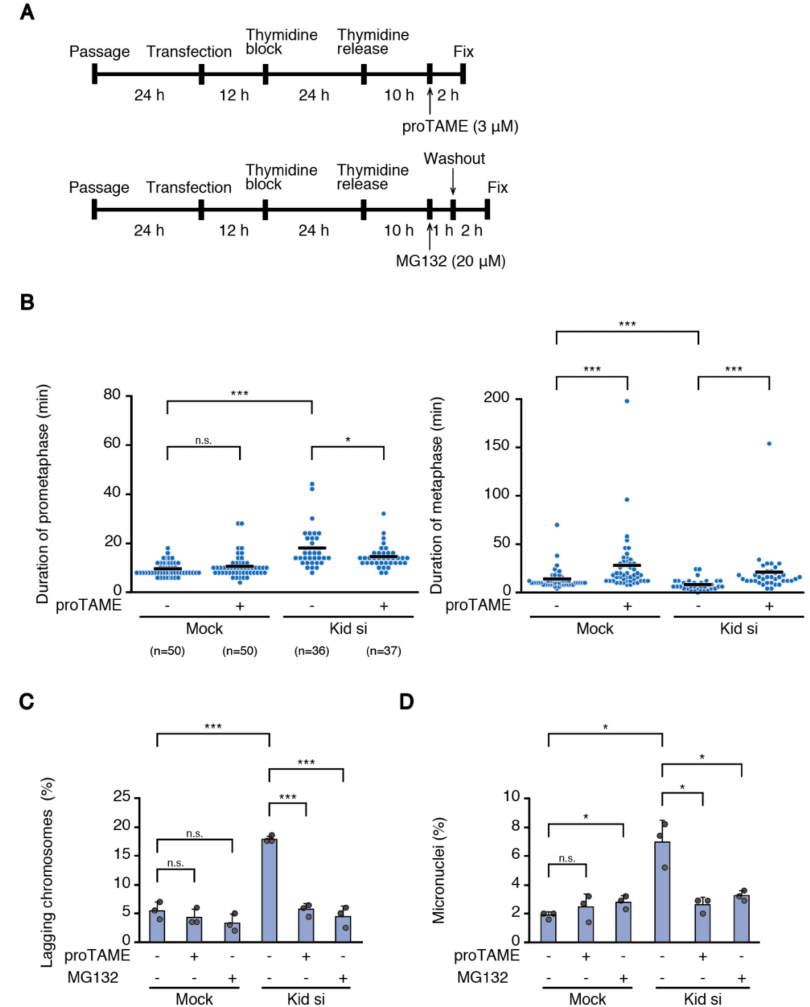
Figure 6. Delaying anaphase onset ameliorates chromosome missegregation in Kid-depleted cells. ( A ) Experimental procedure to treat cells with proTAME (upper), or MG132 (lower), after RNAi; ( B ) duration of prometaphase (left) or metaphase (right) in proTAME-treated cells. HCT116 cells expressing H2B-mCherry were transfected with or without the siRNA for Kid (#1), and treated with or without proTAME, according to the procedure shown in ( A ). Number of cells observed is shown. The average is indicated with a bar. n.s., not statistically significant, * p < 0.05, *** p < 0.0005 (Mann-Whitney U test); ( C ) proportion of lagging chromosomes in Kid-depleted cells treated with proTAME or MG132. For each condition, 200 cells were observed. Experiments were repeated three times, and the average of each experimental result is shown as a dot. Error bars represent SD. n.s., not statistically significant, *** p < 0.0005 (Student’s t -test); ( D ) proportion of micronuclei formation in Kid-depleted cells treated with proTAME or MG132. For each condition, 1000 cells were observed. Experiments were repeated three times, and the average of each experimental result is shown as a dot. Error bars represent SD. n.s., not statistically significant, * p < 0.05 (Student’s t -test and Welch’s t